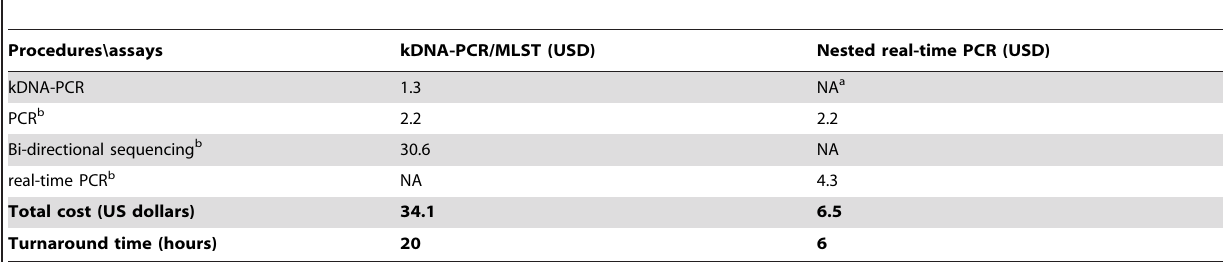
Table 7. Turnaround time and cost analysis per sample for the nested real-time PCR and MLST assays for the identification of Leishmania species from clinical specimens {